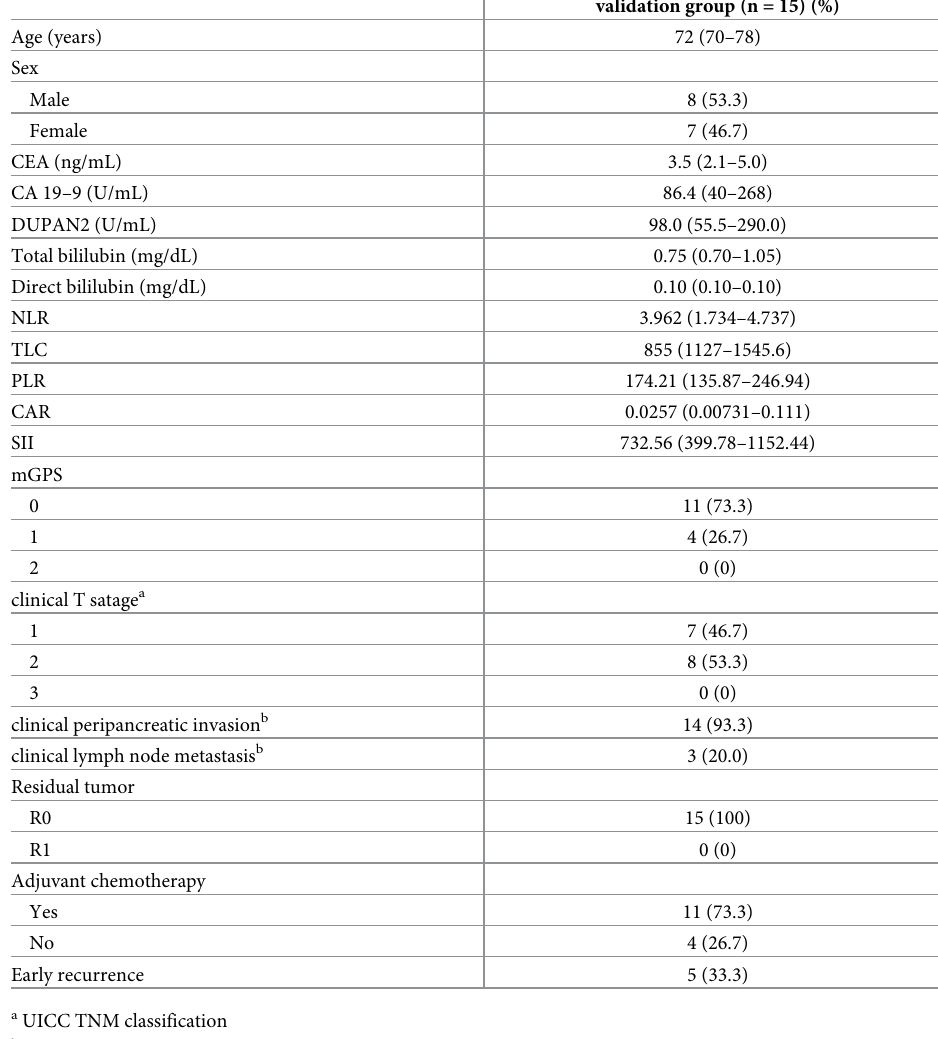
Table 3. Baseline clinicopathological characteristics of the validation